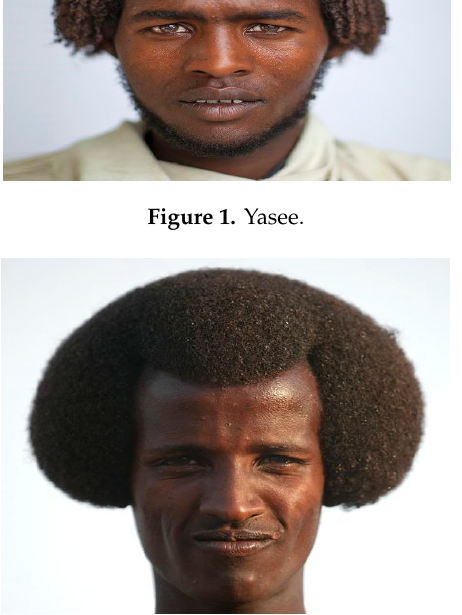
Figure 2. Gunfura / Gunfuree 16 Figure 2. Gunfura/Gunfuree 16 .